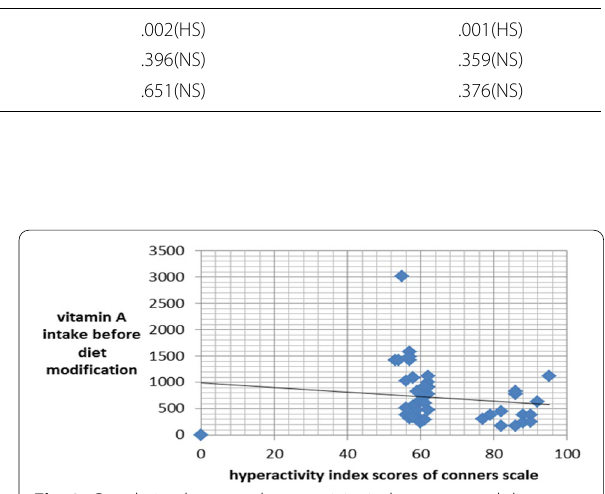
Fig. 3 Correlation between hyperactivity index scores and dietary vitamin A intake during baseline period